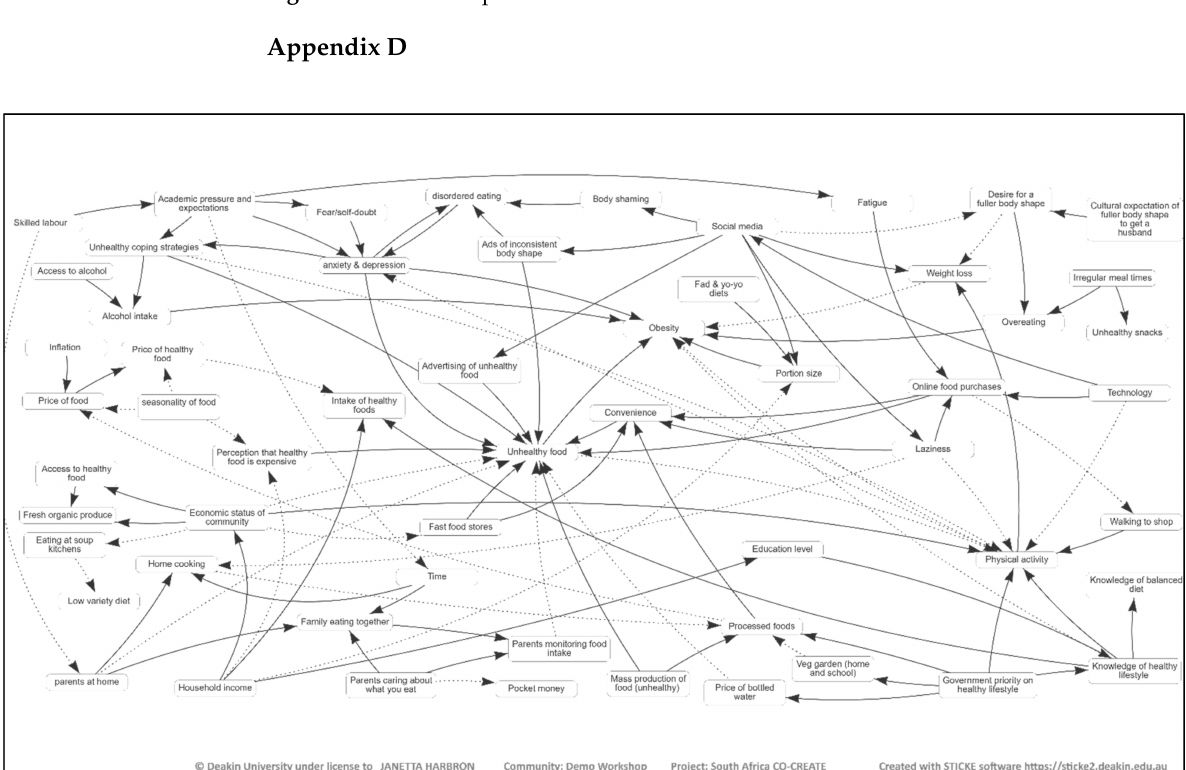
Figure A2. School map 2#.